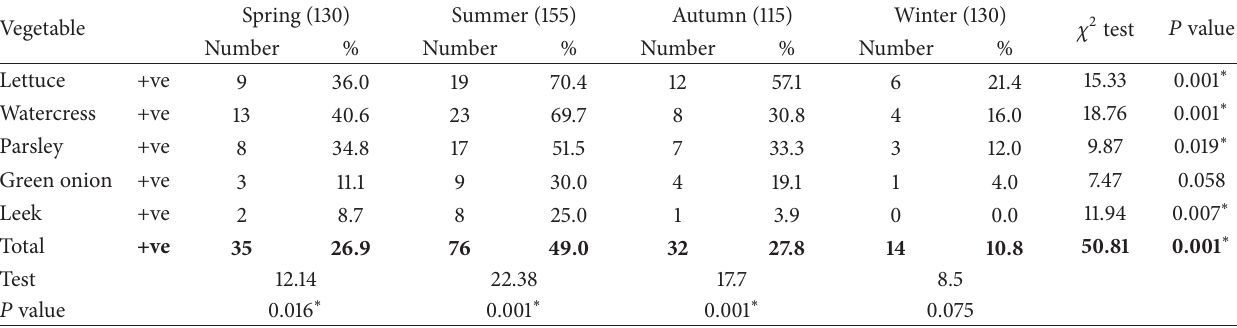
Table 3: Number and percentage of contaminated samples with intestinal parasites in different seasons in the examined fresh leafy vegetables. Spring Vegetable